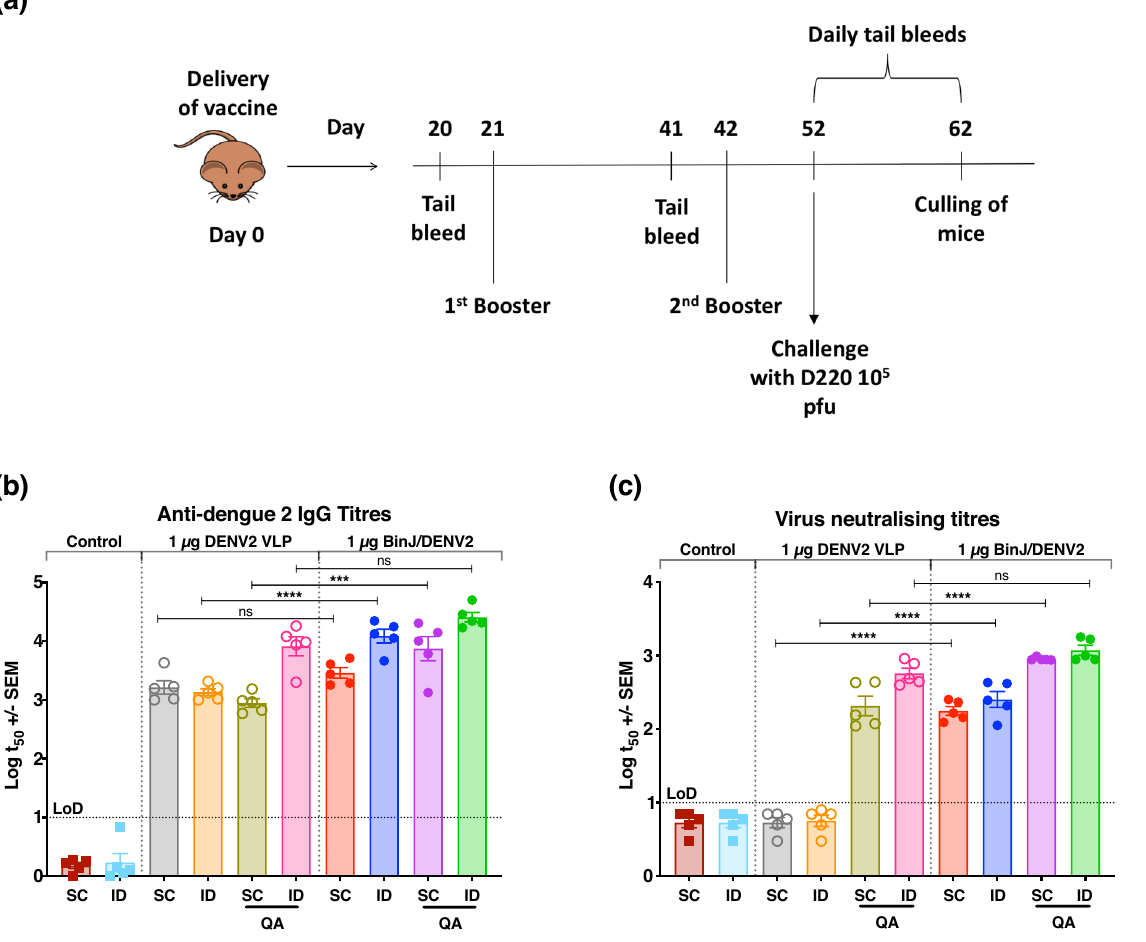
Fig. 2 Evaluation of BinJ/DENV2-prME and DENV2 VLP vaccines in female AG129 mice. a Experiment time course. Female AG129 mice ( n = 5) were vaccinated via ID or SC injection with 1 µg of BinJ/DENV2-prME or DENV2 VLP, with or without 3 µg of QA. Booster doses were given on days 21 and 42, and tail bleeds were taken on days 20, 41 and 51 after the fi rst vaccination. Mice were challenged 10 days post fi nal vaccination and daily tail bleeds were taken for 10 days to monitor survival, viremia and circulating NS1 levels. b The IgG response was determined for sera taken 10 days after the fi nal vaccination and mid-point antibody titres (t50) plotted. c Neutralizing antibody titres 10 days post fi nal vaccination expressed as PRNT 50 against DENV ET00. Note: each symbol represents a single mouse. Lines indicate mean antibody titres with bars showing ±SEM. **** p ≤ 0.0001, *** p ≤ 0.0003, ** p ≤ 0.002, * p ≤ 0.03 assessed by one-way analysis of variance (ANOVA, α - level